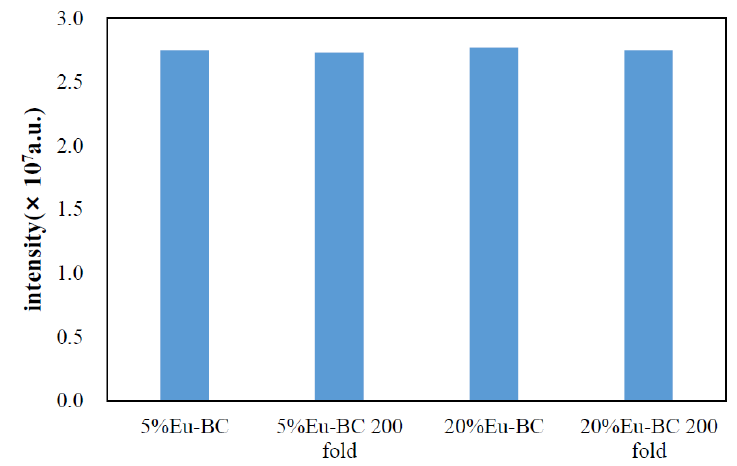
Figure 7. Changes of fluorescence emission spectra at 618 nm for Eu-BC fluorescent paper after 200 foldings.